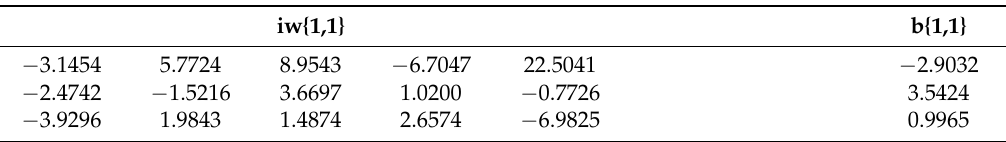
Table A1. Final Weights and Bias Values of the optimum FF-NN model 5-7-7-1 for the case of compressive strength of sandcrete